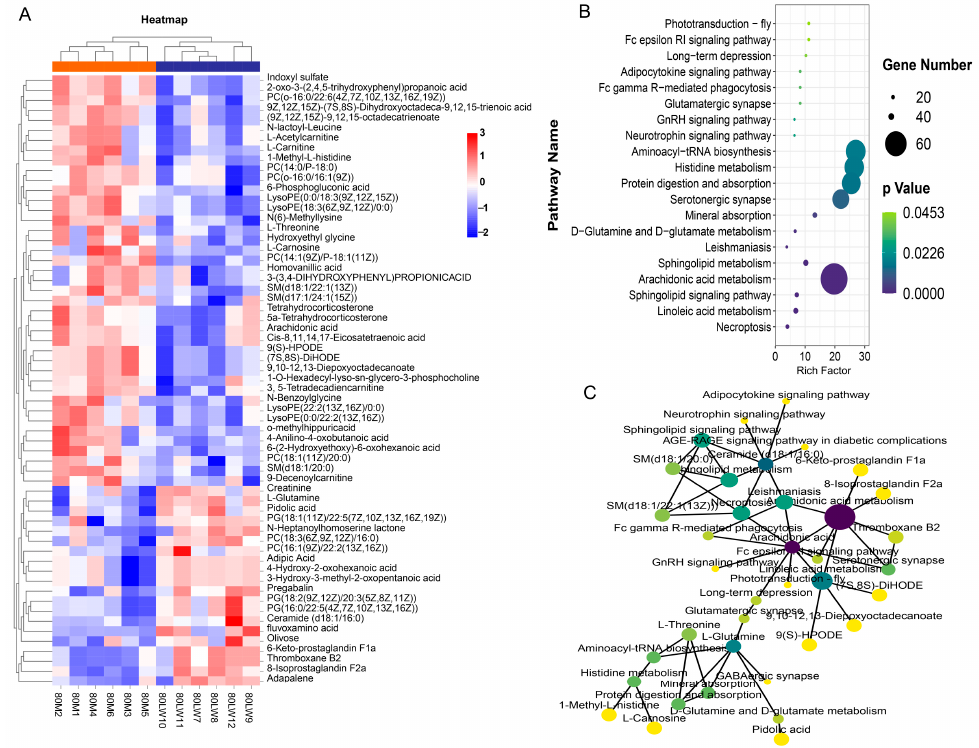
Figure 2. Quantitative metabolomics of LW and M pig serum samples. ( A ) Hierarchical clustering based on differential metabolites in the serum of LW and M pigs. The differentially expressed metabolites (DEMs) were identified with a VIP > 1 and p -value ≤ 0.05. Significantly altered metabolites are highlighted in red (increased) and blue (decreased); ( B ) Kyoto encyclopedia of genes and genomes (KEGG) pathway enrichment analysis of DEMs; ( C ) KEGG network diagram. The number of metabolites enriched into the pathway determines the node size, and the p -value determines the node color.